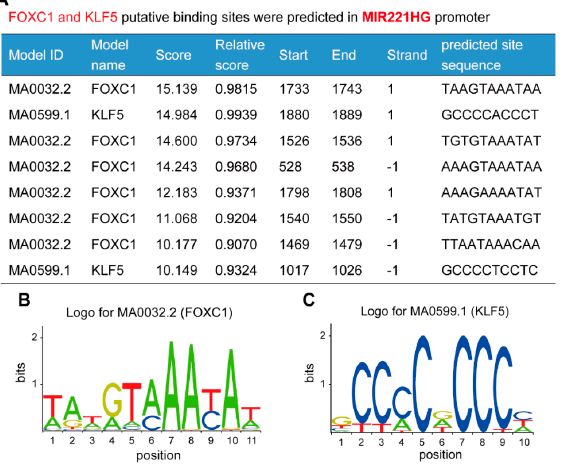
Figure 3. Multiple forkhead box C1 (FOXC1) and krüppel-like factor5 (KLF5) putative binding sites are predicted in the MIR221HG promoter region. ( A ) Predicted FOXC1 and KLF5 binding sites within a 2000-bp region of the MIR221HG promoter. ( B ) FOXC1 binding motif sequence logo from JASPAR. ( C ) KLF5 binding motif sequence logo from JASPAR.